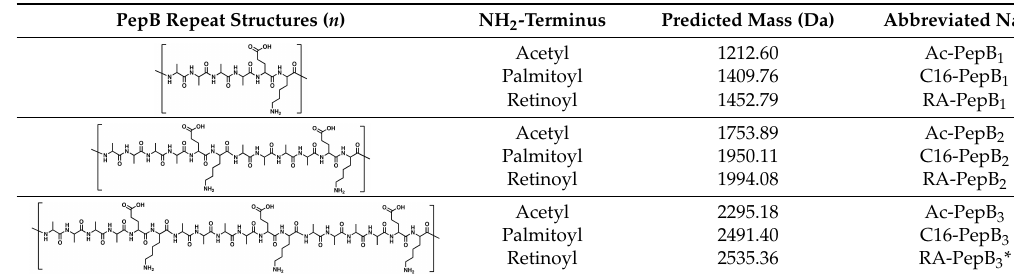
Figure 1. Chemical structure of PepB. Amine terminus R group (green): (I) acetyl (Ac), (II) palmitoyl (C16), or (III) retinoyl (RA); red: rhodamine dye; orange: carboxylic acid (negative charge); blue: primary amine (positive charge). The repeat sequence (AAAAEK) is repeated up to three times ( n = 1, 2, 3) for this study. Table 1. Molecular weight details for PepB variants. Acetyl, palmitoyl, and retinoyl tail chemical (molecular) structures are provided in Figure 1. Please note that there is an extra alanine at the C-terminus and an extra lysine (for dye conjugation) at the N-terminus. * PepB variant ultimately utilized for the differentiation study detailed in Section 3.5. RA: retinoic